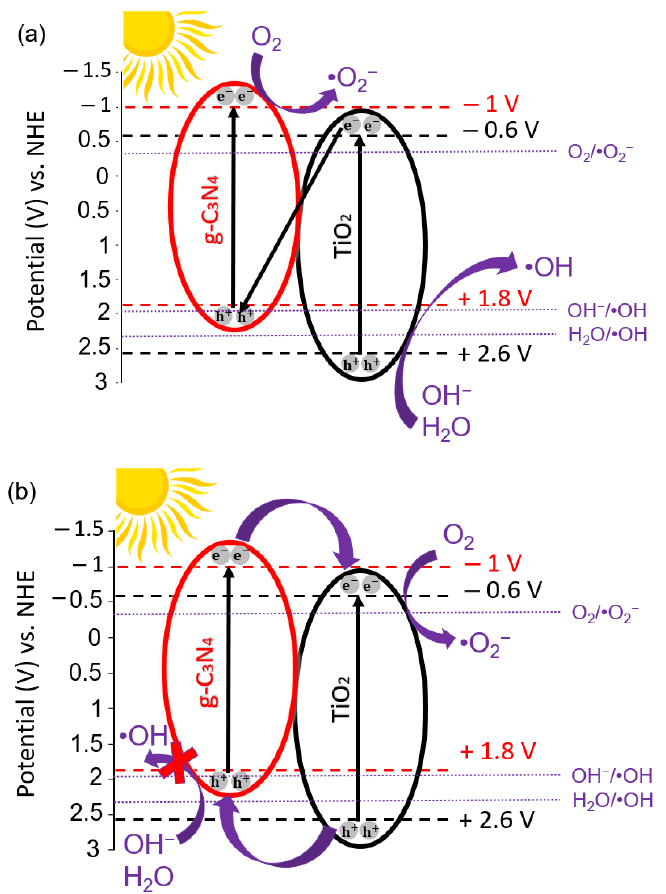
Figure 13. Illustrated mechanism of the photocatalytic activity of the 30-GCN-T heterostructure under solar simulating light. The potentials (V) relative to NHE scale are also represented. Black and red dashed lines correspond to the CB/VB potentials of TiO 2 and g-C 3 N 4 , respectively. Purple dot lines are related to the redox potentials of the common reactive species in photocatalysis. ( a ) repre- sents a possible Z-scheme photocatalytic degradation mechanism of the 30-GCN-T heterostructure, and ( b ) represents a possible type-II photocatalytic degradation mechanism of the 30-GCN-T heter- ostructure.